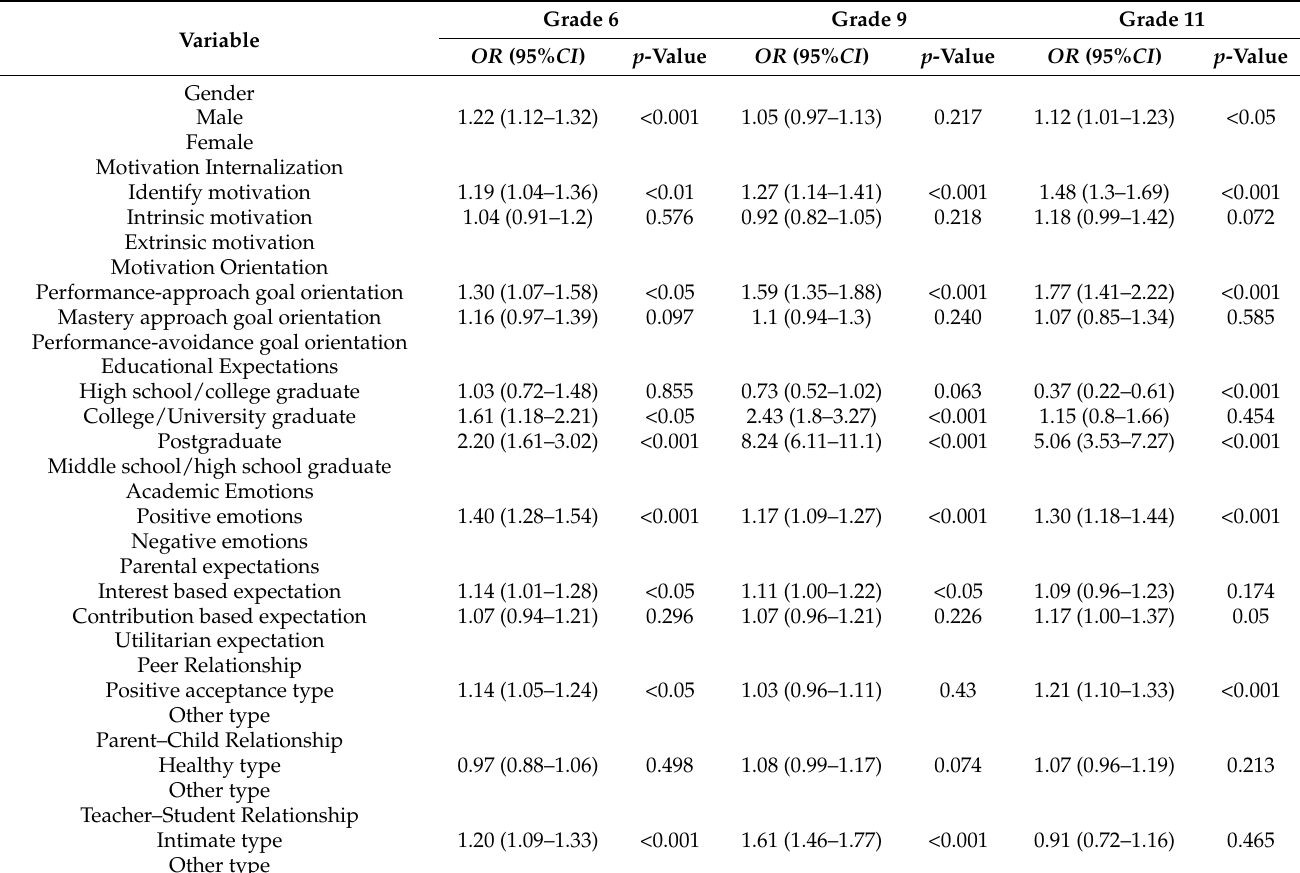
Table 4. Multivariable logistic regression analysis of students’